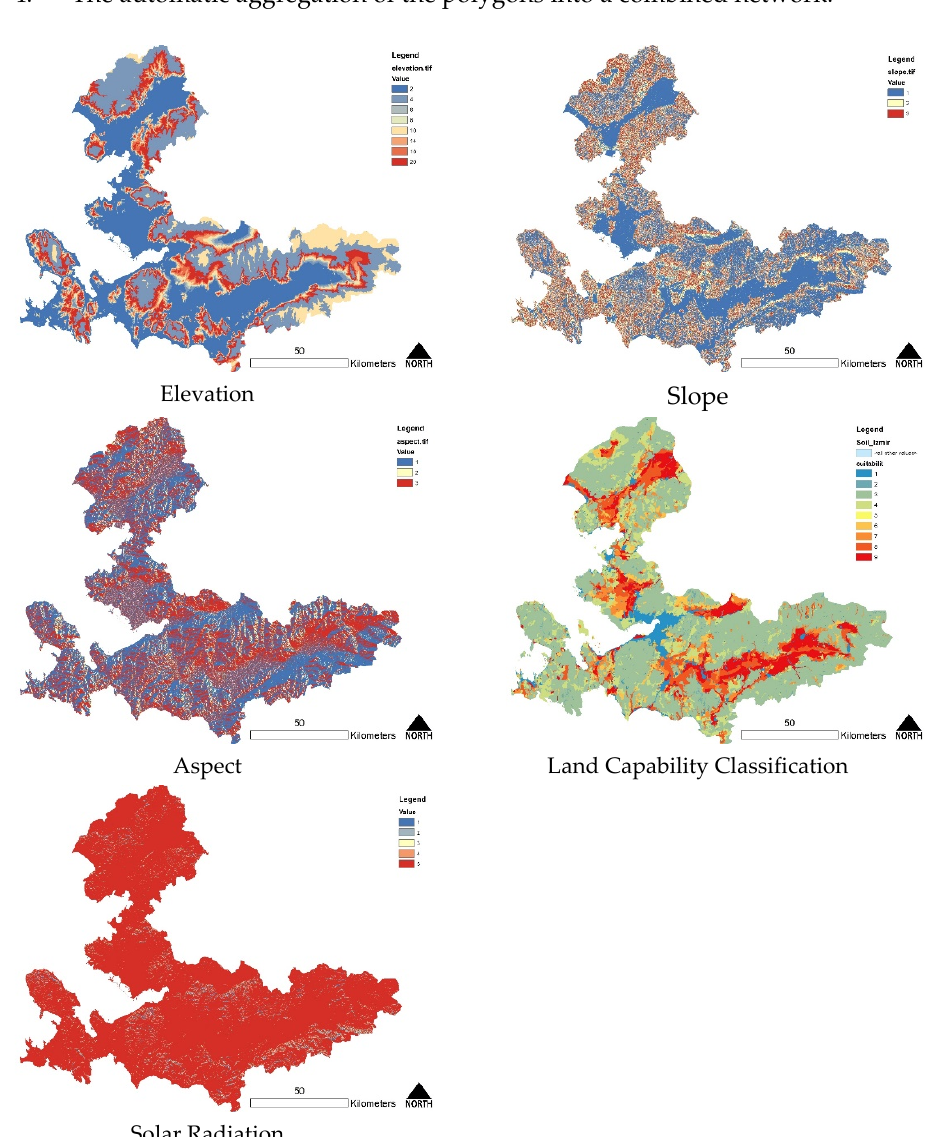
Figure 2. GIS spatial categorization of the five analytical input layers. Source: author’s elaboration.